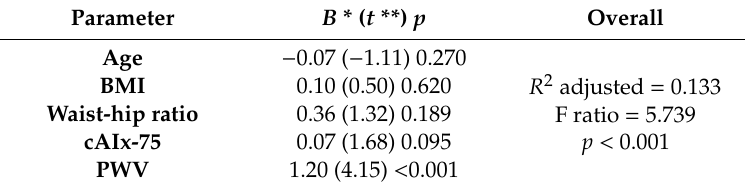
Table 6. Multiple linear regression analysis of selected variables as independent predictors of